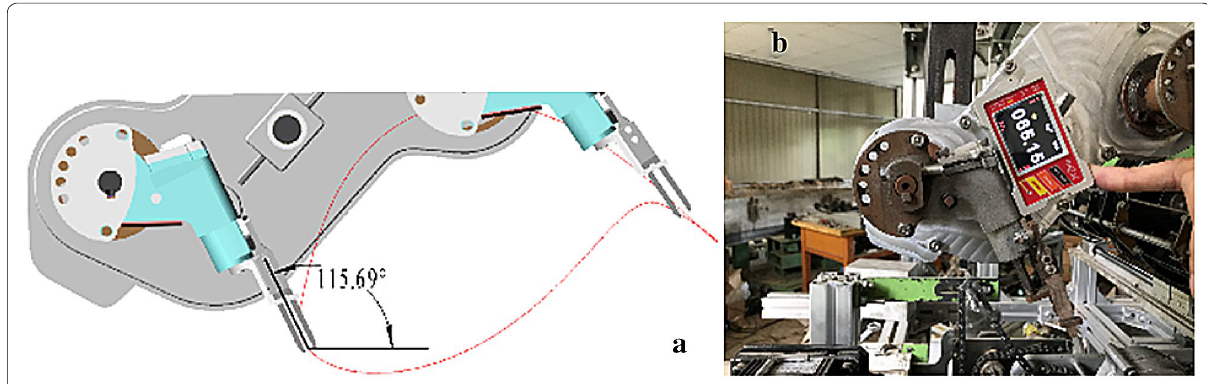
Figure 19 Rod angles at point 5: a virtual and b physical result